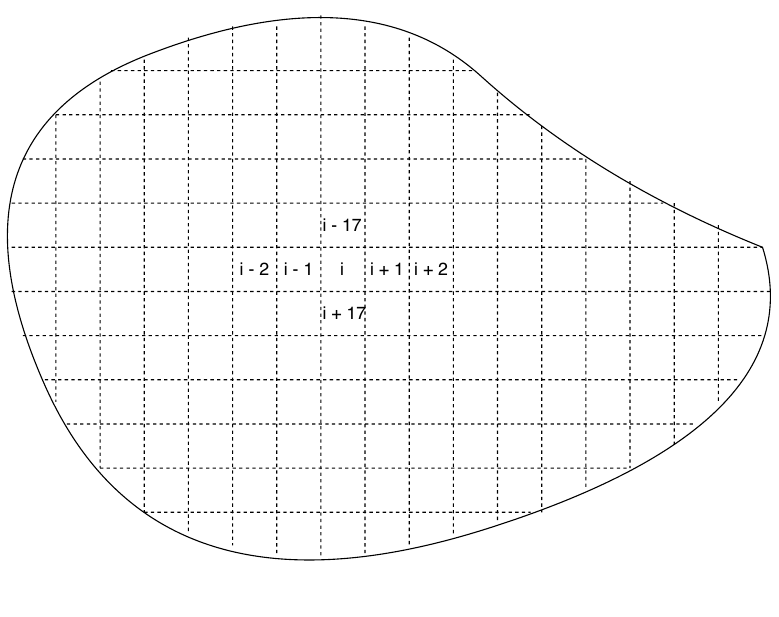
Figure 7. Construct the semantic match via the location-based grid in nature.